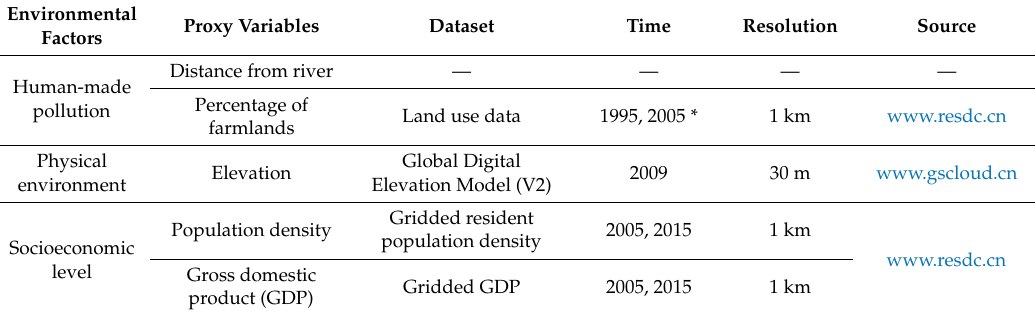
Table 1. Overview of proxy variables and data source.